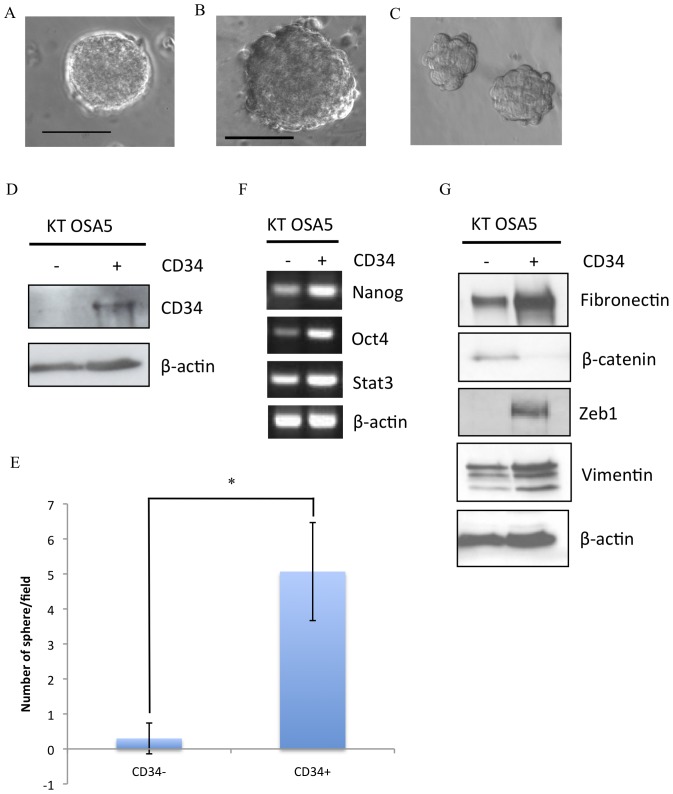
Characterisation of osteosarcoma stem cells.Spheres can be isolated from canine KTOSA5 cells (A), the human U2OS cell line (B), human SAOS2 cell line (C). A small population of CD34+ cells can be isolated from the KTOSA5 cell line by magnetic cell sorting. Only CD34+ cells express CD34 protein (D) and only CD34+ cells could form spheres (E). Data are representative of three independent experiments (*p<0.001). Reverse transcriptase (RT)-PCR analysis of Nanog, Oct4, STAT3, and β-actin gene expression levels (F). Western blots analysis of Fibronectin, β-catenin, Zeb1, and Vimentin, with β-actin as a loading control (G).